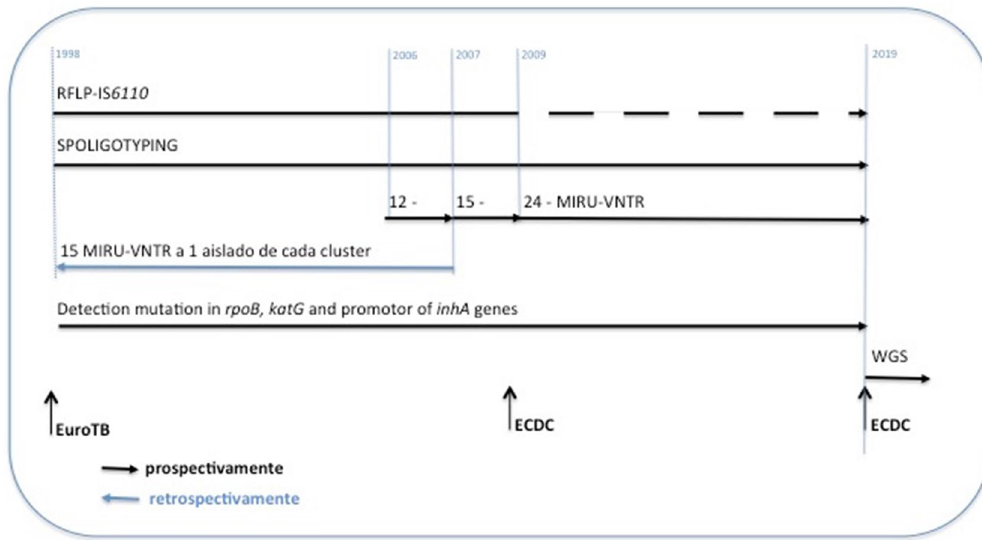
Figure 1. Diverse methods used along the study. From 1998 to 2009, IS 6110 -RFLP was the genotyping applied method. Standard 12-MIRU-VNTR was introduced in 2003, 15-MIRU-VNTR in 2006 and 24-loci MIRU- VNTR typing in 2009. Complementary, one isolate representative of each IS 6110 -RFLP cluster was genotyped by the 24-MIRU-VNTR. Spoligotyping and mutations in katG gene and promoter region of inhA gene were performed on all isolates of the study. Spoligo-International-Type (SIT) labels were